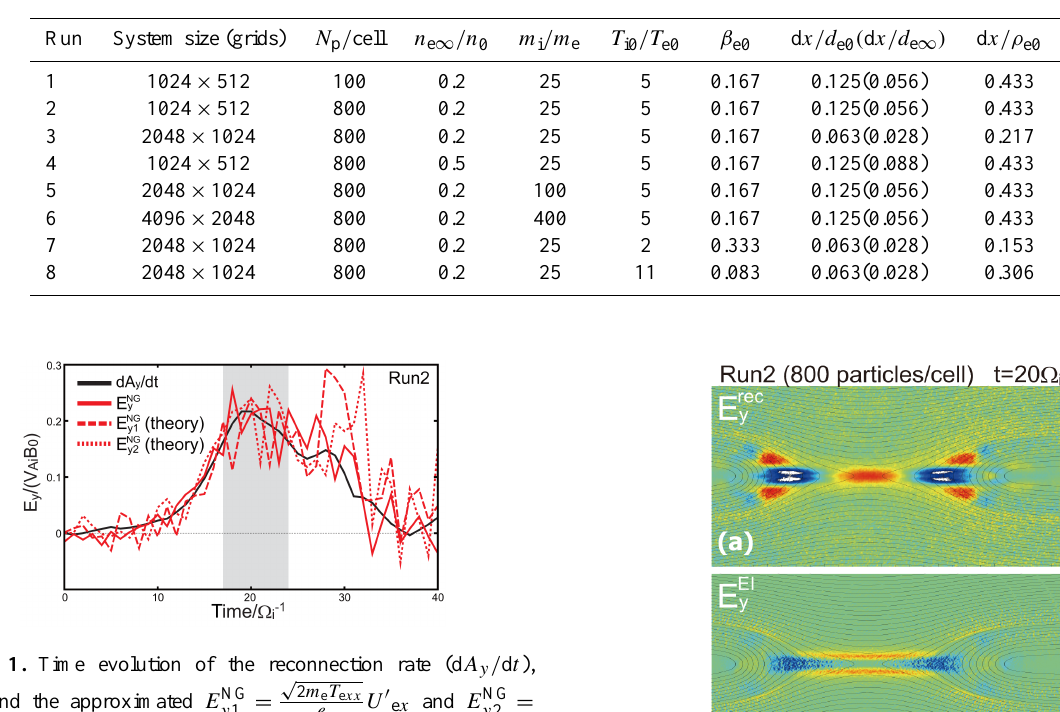
Table 1. System size, N p / cell, m i /m e , T i0 /T e0 , β e0 and d x normalized by d e0 (d e ∞ ) and ρ e0 for each run shown in this paper.